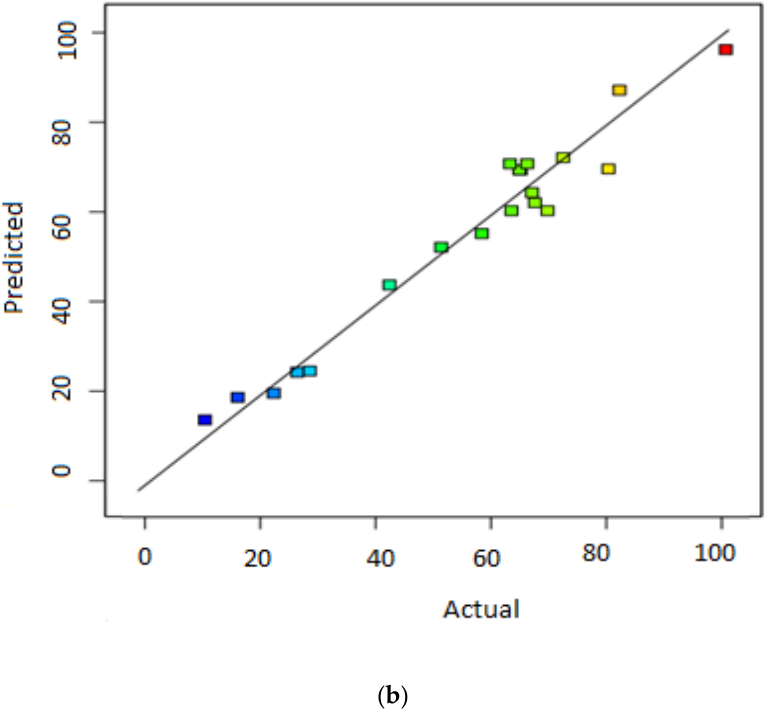
Figure 1. Actual and predicted plots for ( a ) COD removal and ( b ) color removal.